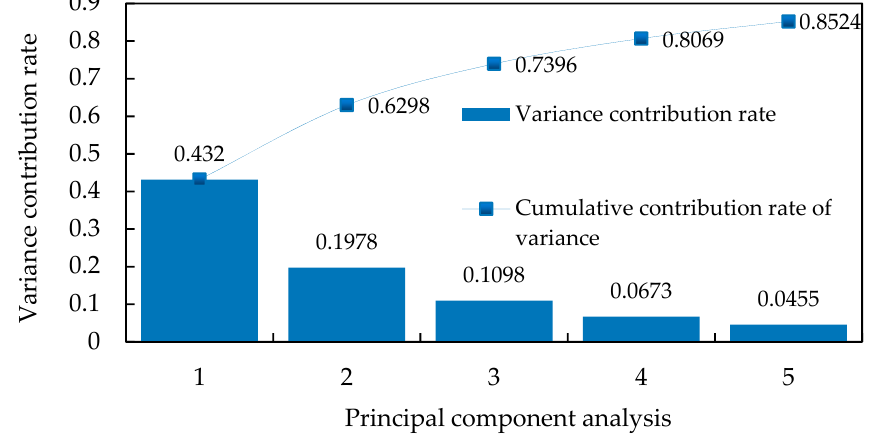
Figure 7. The results of principal component analysis for 11 reference indexes.